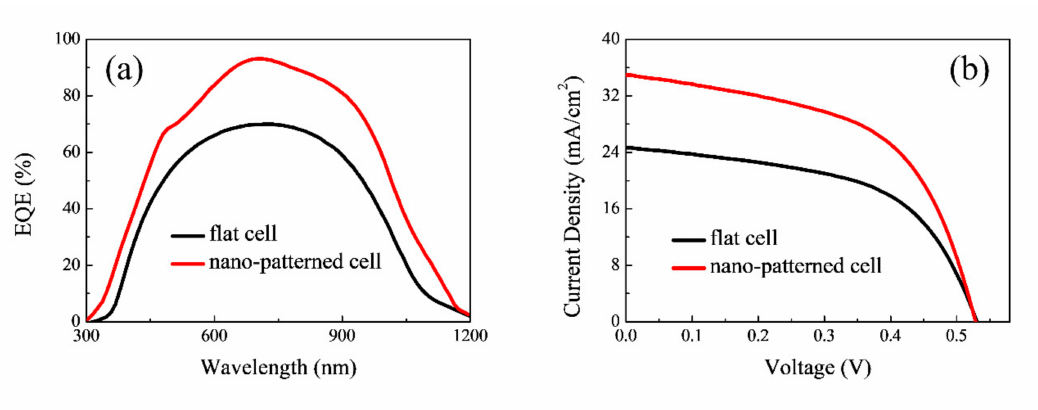
Figure 8. ( a ) EQE spectra and ( b ) AM1.5G illuminated J - V curves of Si QDs / SiC MLs-based solar